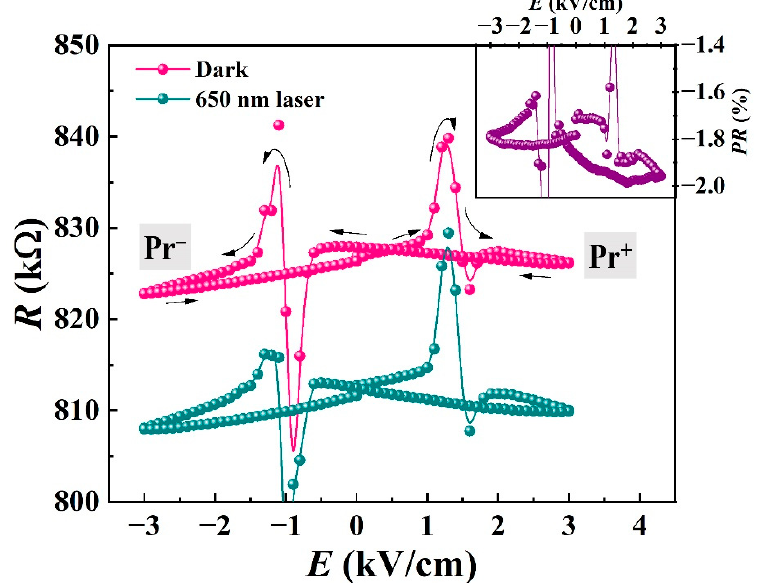
Figure 2. The film resistance R as a function of bipolar electric field E at room temperature with (red cycle) or without (green cycle) light irradiations. The inset shows the dependence of PR on the bipolar electric field E .